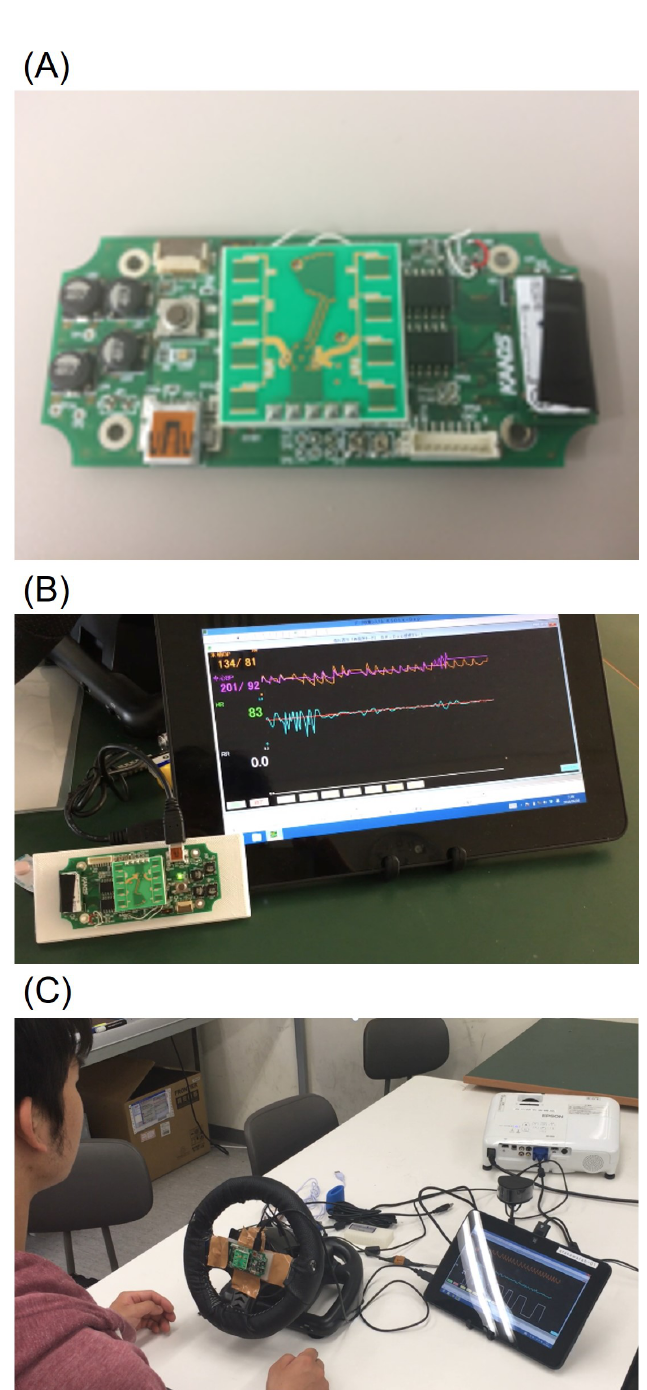
Figure 5. A portable device-type system developed by Arakawa et al.: ( A ) developed portable device-type system ( B ) appearance of the system and interface that shows the current blood pressure; ( C ) demonstration of the operation of the